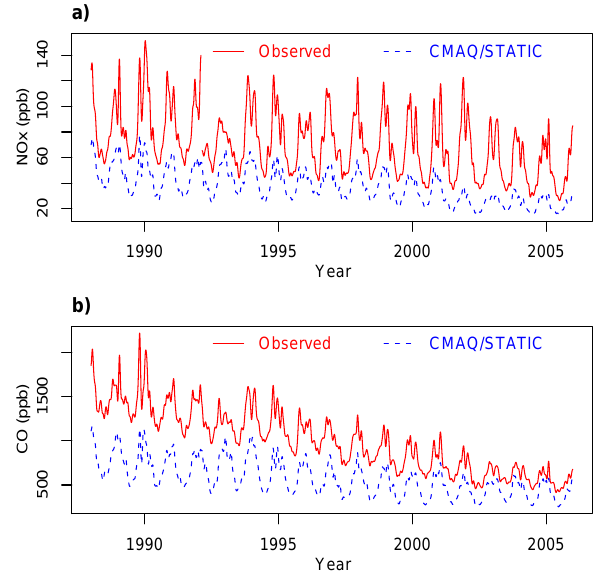
Fig. 8. Observed and CMAQ/STATIC baseline time series of NO x (top) and CO (bottom). The results represent a spatial average over 3 monitors for NO x and 34 monitors for CO. Only concentrations between 06:00 and 09:00 local time were considered in this analy-